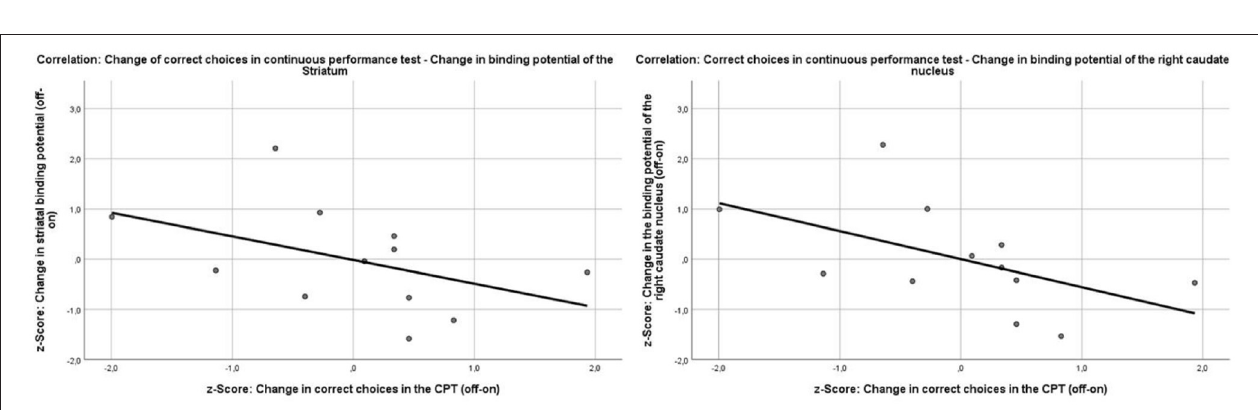
FIGURE 6 | Correlations between the change of the binding potentials in the striatum (Pearson r = − 0.45, p = 0.14) and the right caudate nucleus (Pearson r = − 0.54, p = 0.07) and the change of correct choices in the continuous performance test.